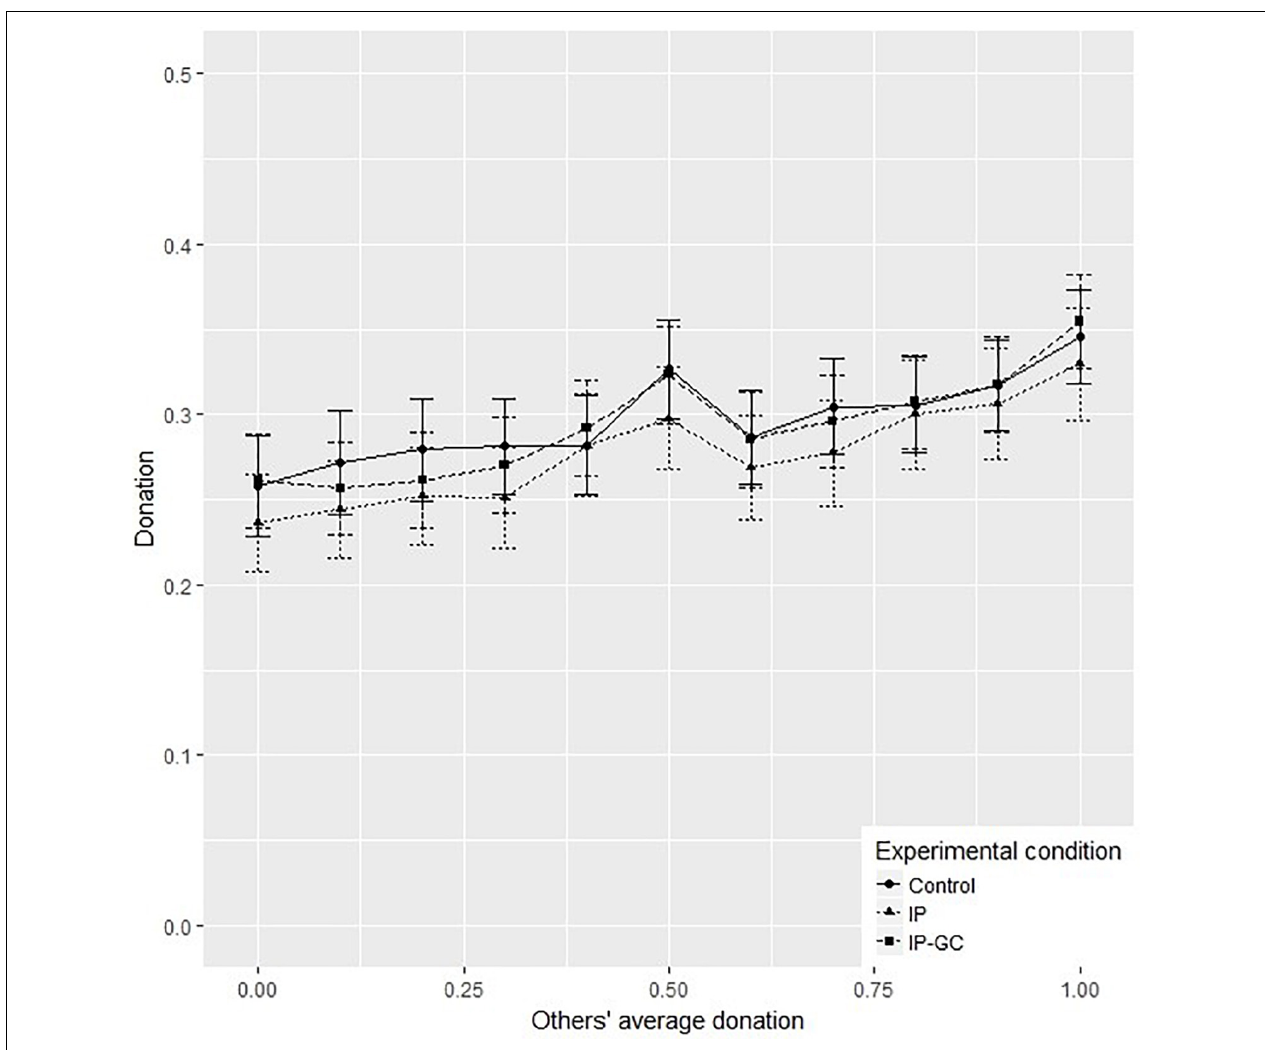
FIGURE 4 | Mean of conditional donation by treatment, Study 2. IP, identity priming; IP – GC, identity priming and goal commitment. Error bars represent 95% confidence